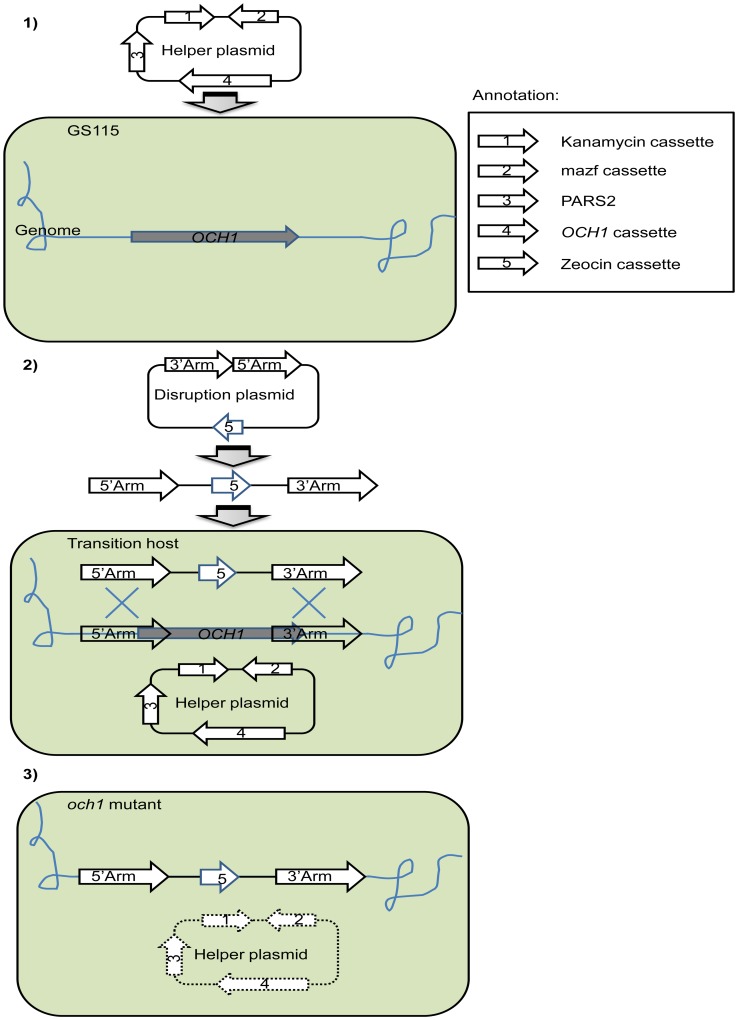
Schematic representation of the new strategy for efficient gene targeting.Take deletion of OCH1 gene as an example. As follows, it’s a three-step process: 1) Generation of the transition host. The helper plasmid, which has the cloned Pichia pastoris OCH1 gene placed under the control of the glyceraldehyde-3-phosphate dehydrogenase (GAP) promoter, was transformed into P. pastoris GS115 strain, thereby generating the transition host for OCH1 gene deletion. The helper plasmid can be maintained within the host cell because of the presence of an autonomous replication sequence (PARS2). 2) Gene disruption. The disruption plasmid for OCH1, which contains the 5′ and 3′ flanking regions of the OCH1 gene, was linearized and transformed into the transition host for gene deletion. 3) Elimination of the helper plasmid. After the chromosomal OCH1 gene was successfully deleted, cells were streaked on an agar plate with methanol to induce the expression of E. coli mazf gene (encoding MazF). MazF toxicity causes a strong selection pressure on the streaked strains and induces the loss of the helper plasmids.